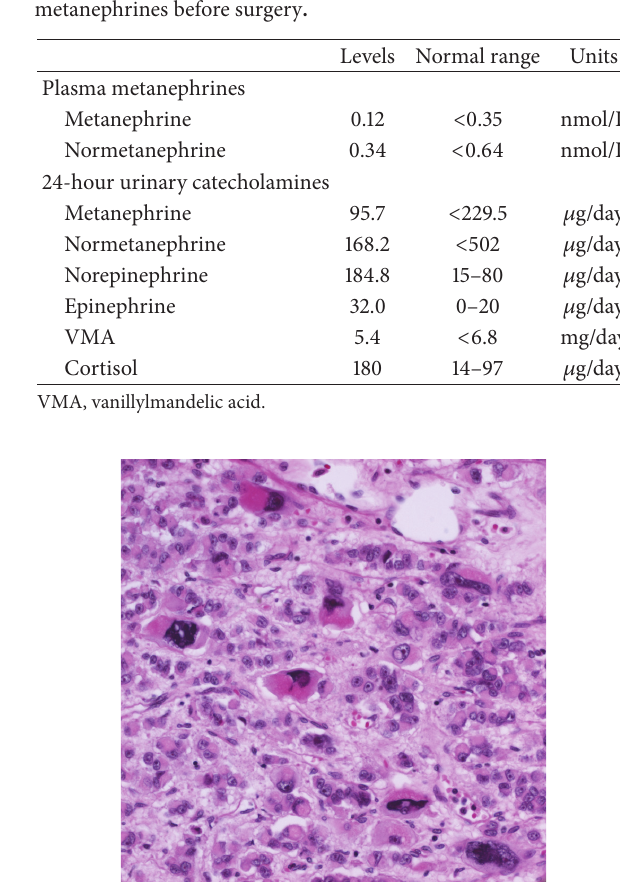
Figure2:Histopathologyshowingmalignantcellsintheadrenocor- tical site (HE stain, × 400), with abundant eosinophilic cytoplasm, enlarged hyperchromatic nuclei, and prominent nucleoli. Several anaplastic cells were also shown in the